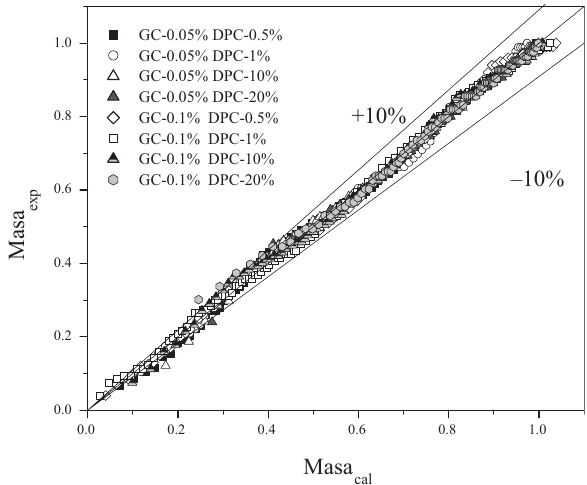
Fig. 11. Correlation between experimental values (massexp) and calculated (masscal) by means of the Hill equation for the entire process of the imbibition process